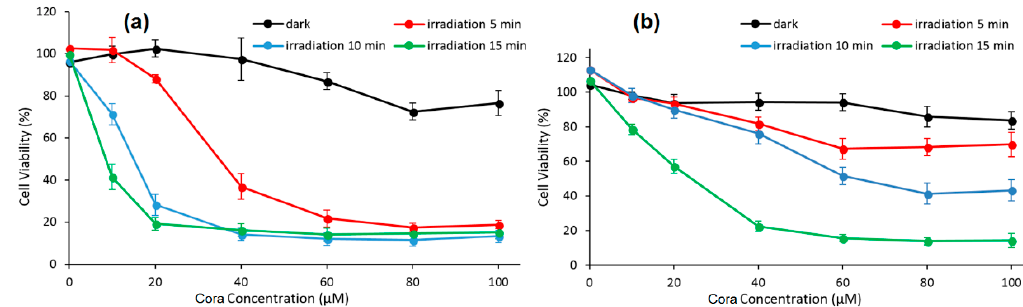
Figure 17. The dose-dependent viability of PC-3 cells in response to ( a ) γ -CD/Cora inclusion complex and ( b ) mPEG-Cora micelle in the absence or presence of light irradiation (365 nm, 95 mW/cm 2 ). Three irradiation times were set at 5 min, 10 min, and 15 min ( n = 3). Adapted from Zhang; Dong; Lu; Liu; Ding; Kong; Fan; Wang; Zhao [132].